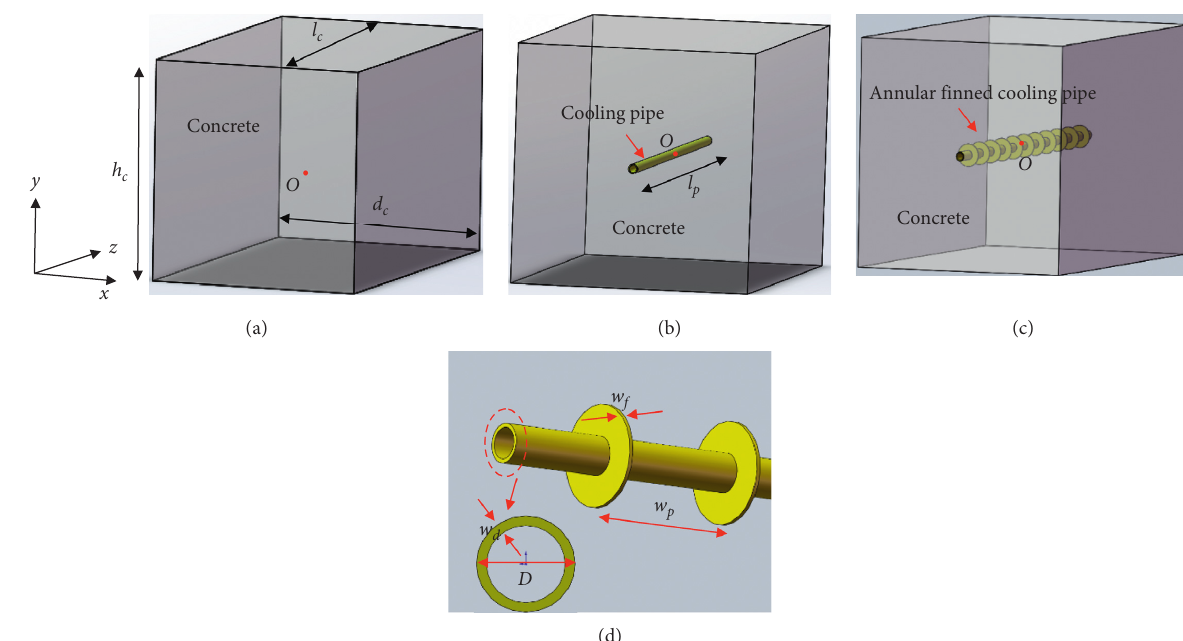
Figure 4: Diagrams of massive concrete: (a) concrete; (b) concrete with the traditional cooling pipe; (c) concrete with the annular finned cooling pipe; (d) enlarged annular finned cooling